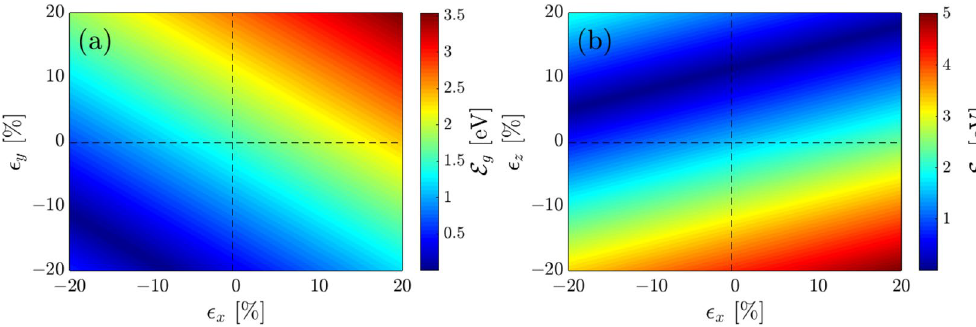
Figure 3. The band gap of monolayer phosphorene in the presence of both uni- and bi-axial compressive and tensile strains for ( a ) ǫ y - ǫ x and ( b ) ǫ z - ǫ x